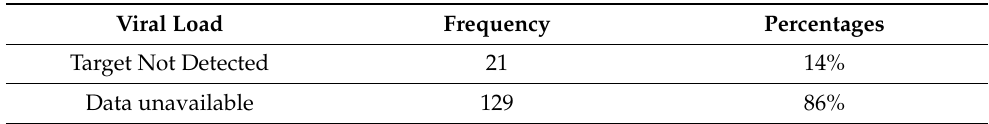
Table 1. Descriptive analysis of viral load in the study population.